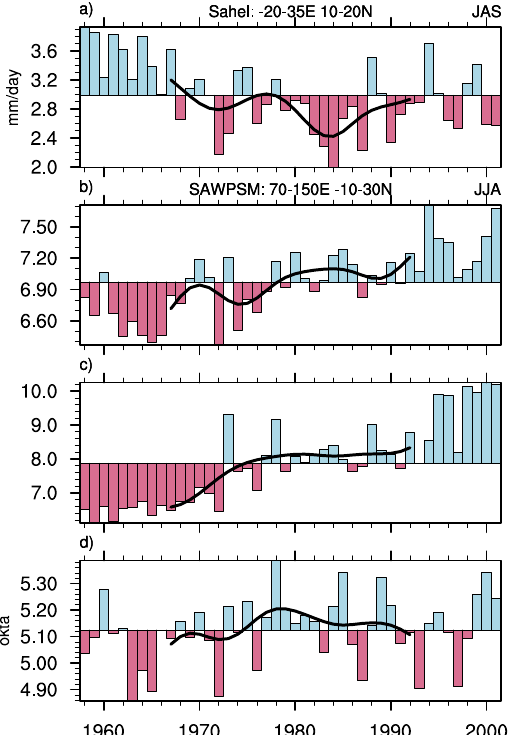
Figure 1. Time series of JAS Sahel rainfall, JJA SAWPSM precipitation and JJA SAWPSM cloudiness. Time series of ( a ) JAS rainfall over the Sahel in the PRECL precipitation data, ( b ) JJA SAWPSM precipitation in the NCEP Reanalysis data, ( c ) JJA SAWPSM precipitation in the ERA-40, and ( d ) JJA SAWPSM cloudiness (bar), and the weighted running average with 9-year Lanczos low-pass filter of the time series (solid line; see Methods). This figure was generated by the NCAR Command Language (Version 6.3.0) [Software]. (2016). Boulder, Colorado: UCAR/NCAR/CISL/TDD.